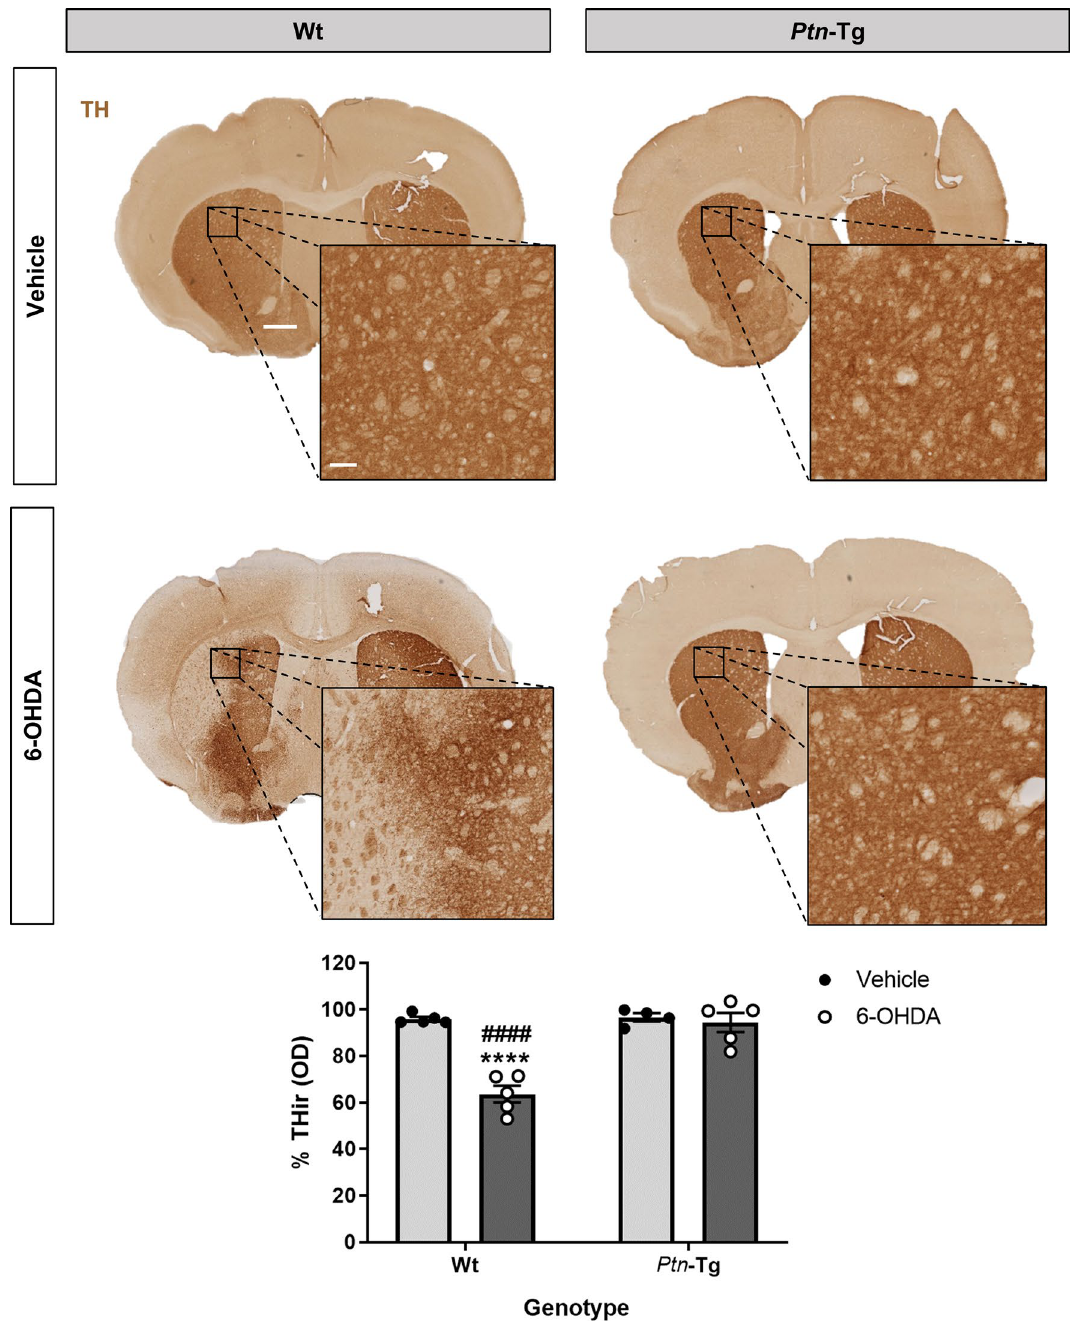
Figure 2. 6-OHDA-induced loss of TH expression in striatum is prevented in Ptn -Tg mice. Photomicrographs illustrate that PTN overexpression prevents 6-OHDA-induced dopaminergic damage. TH-immunostained striatal sections of mice, 10 days after vehicle or 6-OHDA striatal injection. Graph shows the proportional stained area of TH-ir (TH-immunoreactivity) in the striatum. Data are represented as mean ± S.E.M. OD: optical density. ****P < 0.0001 vs. Wt-Vehicle. #### P < 0.0001 vs. Ptn -Tg-6-OHDA. Scale bar = 500 μm (magnification image scale bar = 100